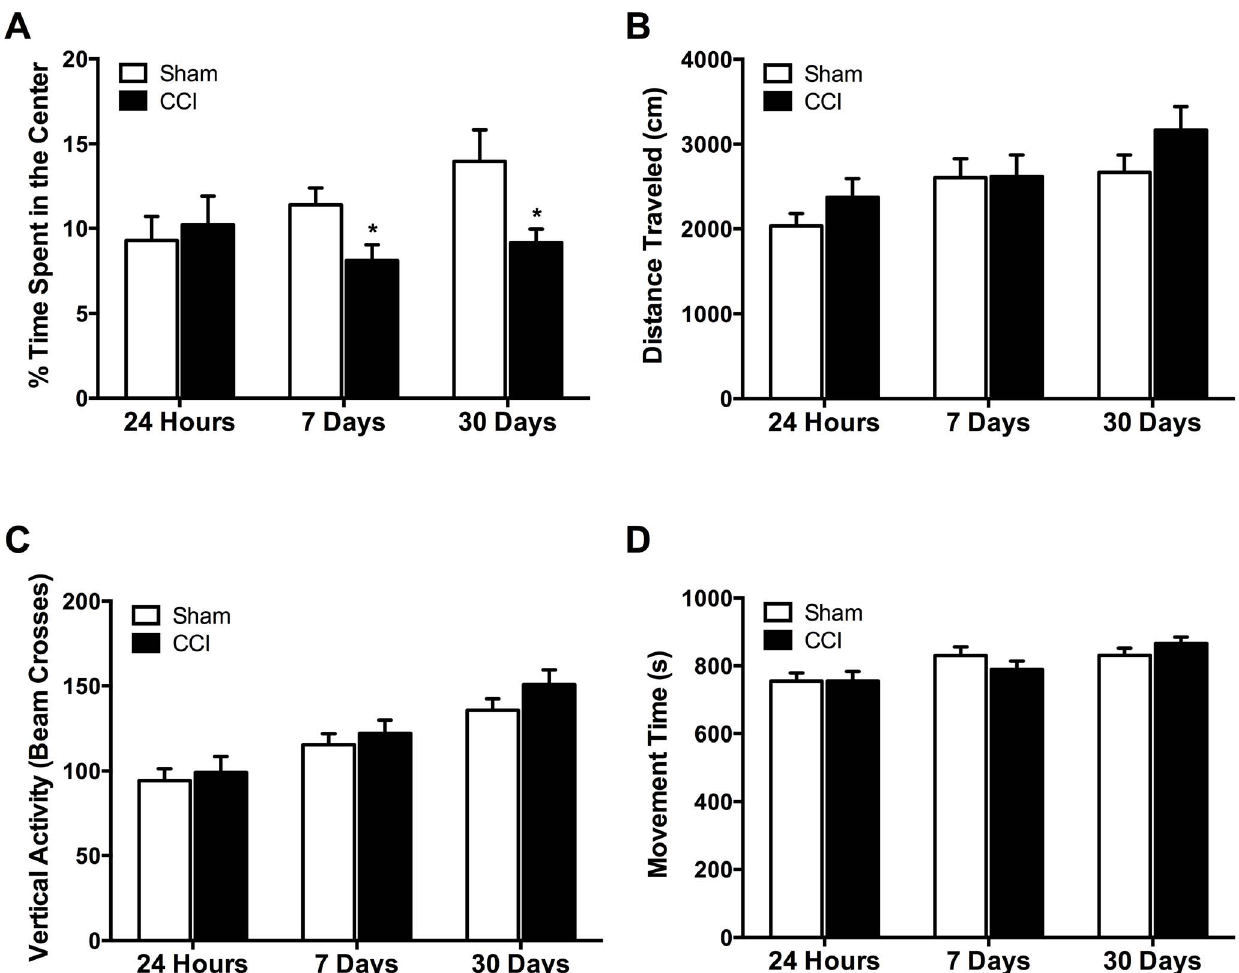
Figure 1. Mild TBI increases anxiety-like behaviors in the open field test. (A) No differences in percent time spent in the center of the open field were found between CCI (n=19) and sham (n=19) animals 24 hours after injury. However, CCI rats spent significantly less time in the center of the open field 7- and 30-days after injury compared to sham animals. No significant differences were found between the sham and CCI animals in distance traveled (B), vertical activity (C), or movement time (D) at any of the time points. Bars show the mean 6 SE of the percentage of time spent in the center (A), distance traveled (B), vertical activity (C), and movement time (D). *p , 0.05.